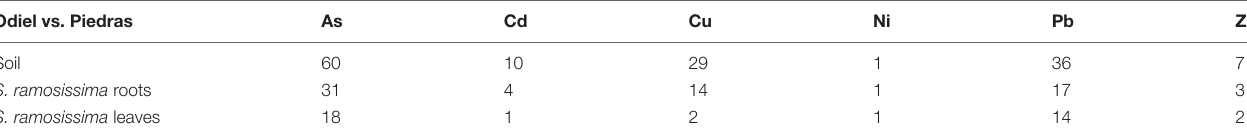
TABLE 5 | Metal(loid) concentrations in mg Kg − 1 found in S. ramosissima leaves and roots growing in non-polluted Piedras sediments after 30 days of experiment. Tissue Treatment As Cd Cu Ni Pb Zn Leaves Non-inoculated Inoculated Root Non-inoculated